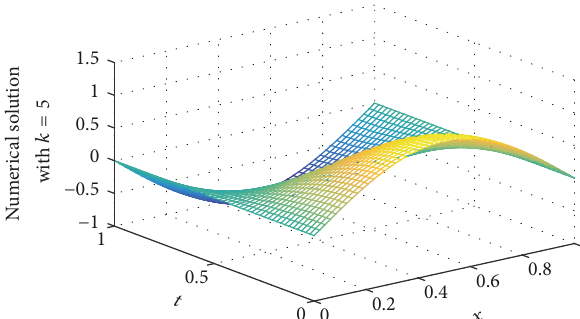
Figure 9: Numerical solution with 𝑘 = 5 .